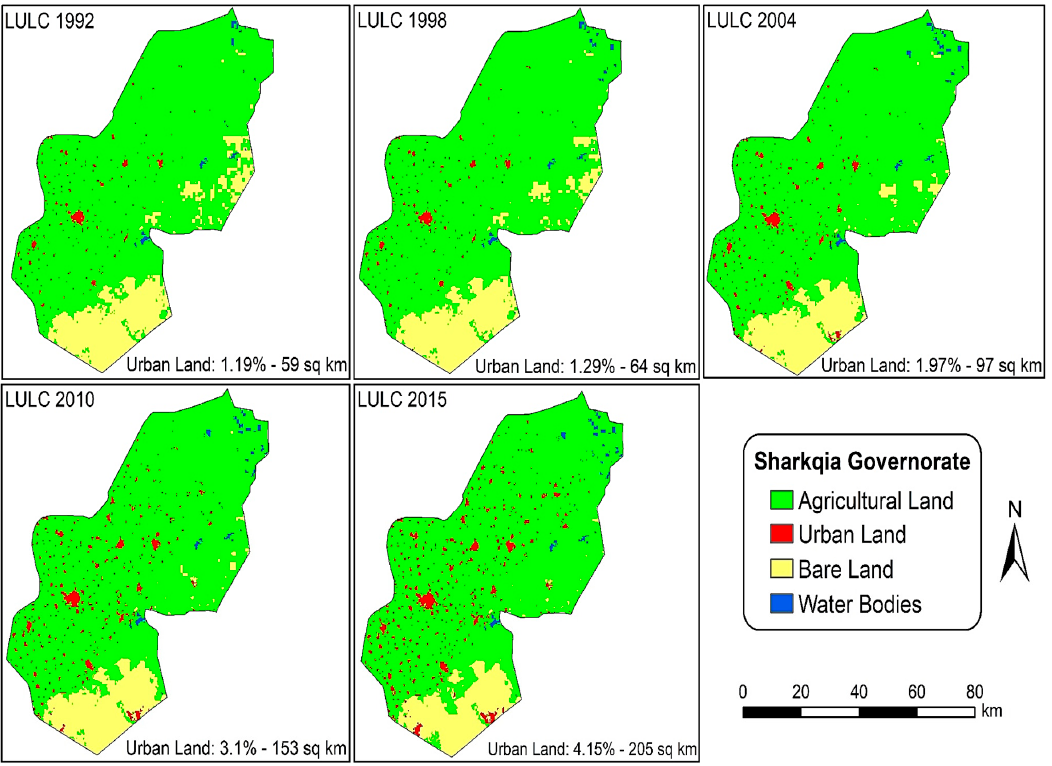
Figure A3. Urban expansion over Sharkqia governorate.